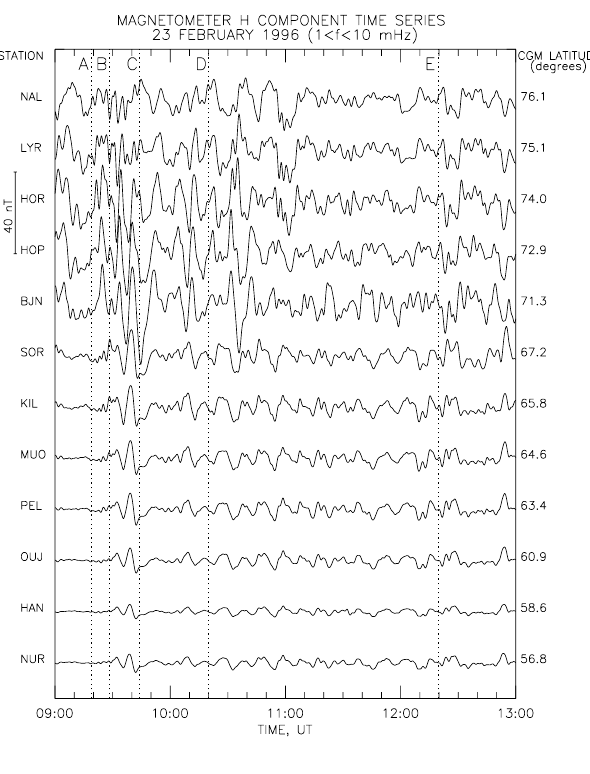
Fig. 5. Stacked power spectra (0.3mHz resolution), over 10:20– 11:20UT, for (a) Finland beam 6 radar velocities (b) Iceland beam 14 radar velocities, and (c) DOPE vertical incidence Doppler shifts.